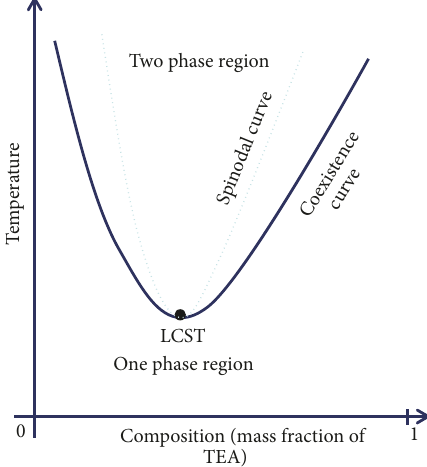
Figure 1: A phase diagram for a case of lower critical solution temperature (LCST)